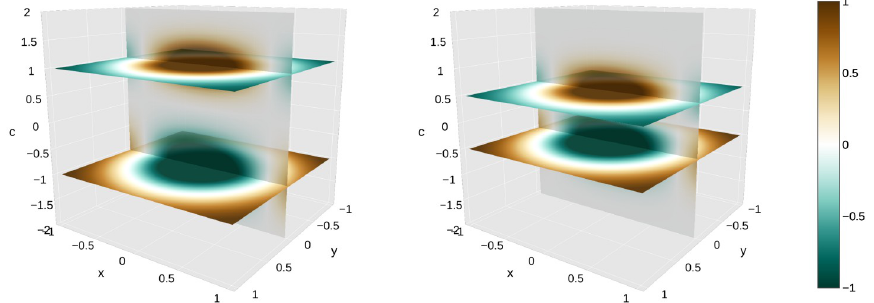
Fig 6. Connectivity kernel in 3D physical and color space. Left. W 1 defined with r 0 = 0 and c 0 = 1. Right. W 2 defined with r 0 = 0 and c 0 = .5. The color bar extends between − 1 and 1, going from dark green (negative values, strong inhibition) to dark orange (positive values, strong excitation). We provide an interactive 3D animation of the connectivity kernels ω ( r 0 , c 0 , � , � ) for all values of c 0 2 C in S1 File. For varying r 0 , the kernel is just spatially translated opp along r 0 . However, for varying c 0 , the positive and negative gaussian kernels in f follow c 0 and − c 0 , collide when c 0 goes through zero, then exchange of position when | c 0 | grows again.